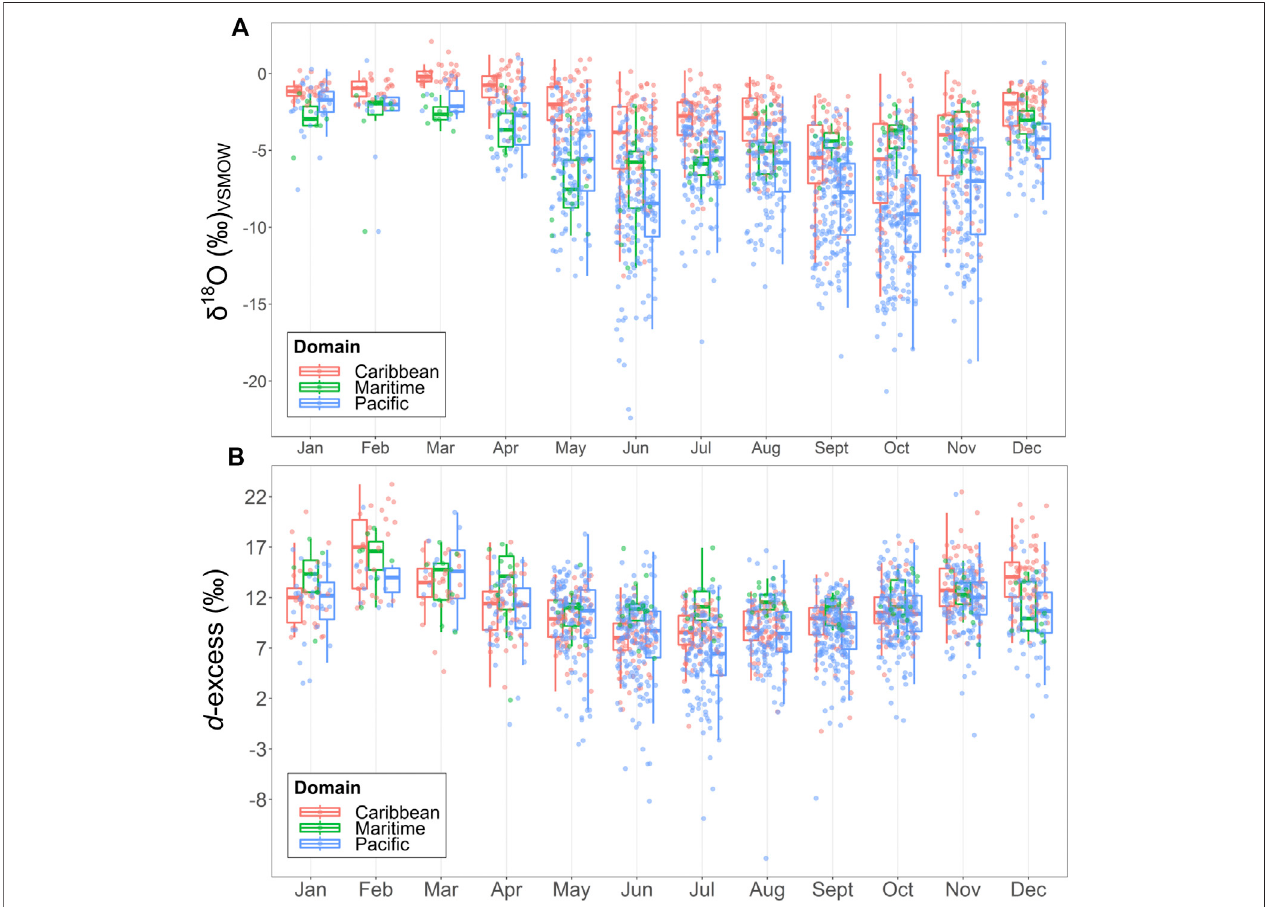
FIGURE 6 | Rainfall isotope time series in continental and maritime domains from 2013 to 2019. (A) δ 18 O and (B) d -excess variations in ‰ . Domains: Caribbean (red), Maritime (Cocos Island, green), and Paci fi c (blue). Figure adapted using data from Sánchez-Murillo et al. (2019a).